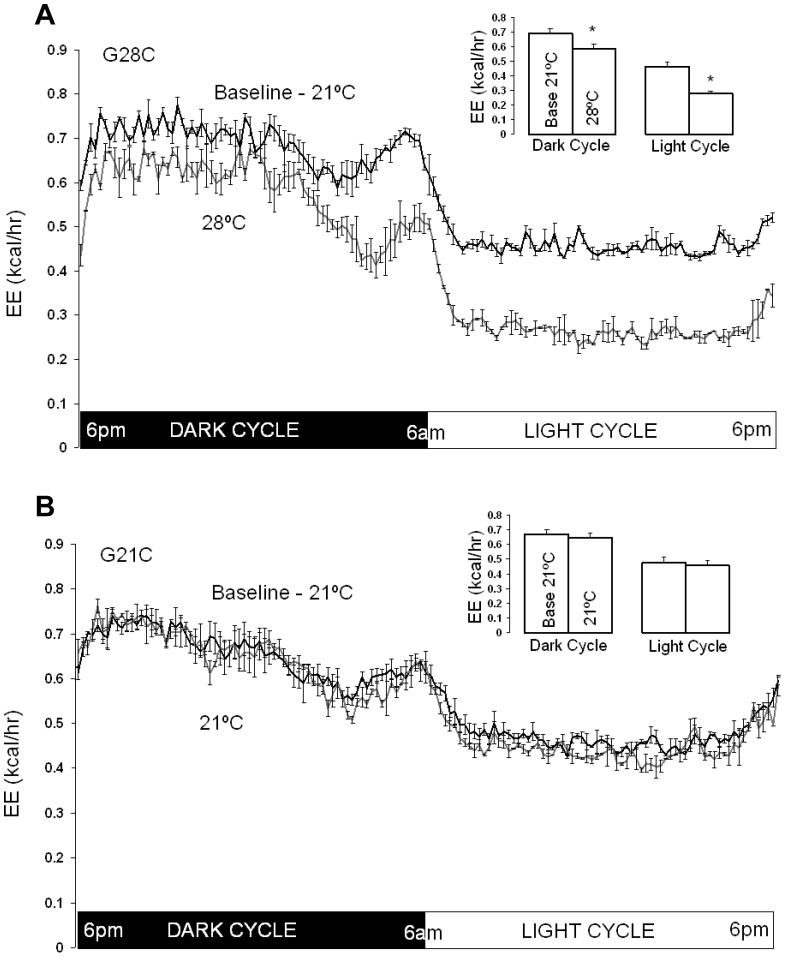
Effect of increased ambient temperature (Ta) on total energy expenditure (EE) in G28C and G21C groups.A. G28C group (n = 8). Mean EE (kcal/hr) rate every 10 min during the entire photoperiod at baseline (21°C) and after increasing Ta to 28°C. Insert: Cumulative mean dark cycle and light cycle EE in G28C mice at baseline (Base 21°C) and after increasing Ta to 28°C (28°C). B. G21C group (n = 8). Mean EE (kcal/hr) rate every 10 min during the entire photoperiod at baseline (21°C) and after maintaining Ta at 21°C. Insert: Cumulative mean dark cycle and light cycle EE in G21C mice at baseline (Base 21°C) and after maintaining Ta at 21°C (21°C). All data shown as means ± SEM for 3 consecutive days, * signifies p<0.05 by pair-wise t-test.